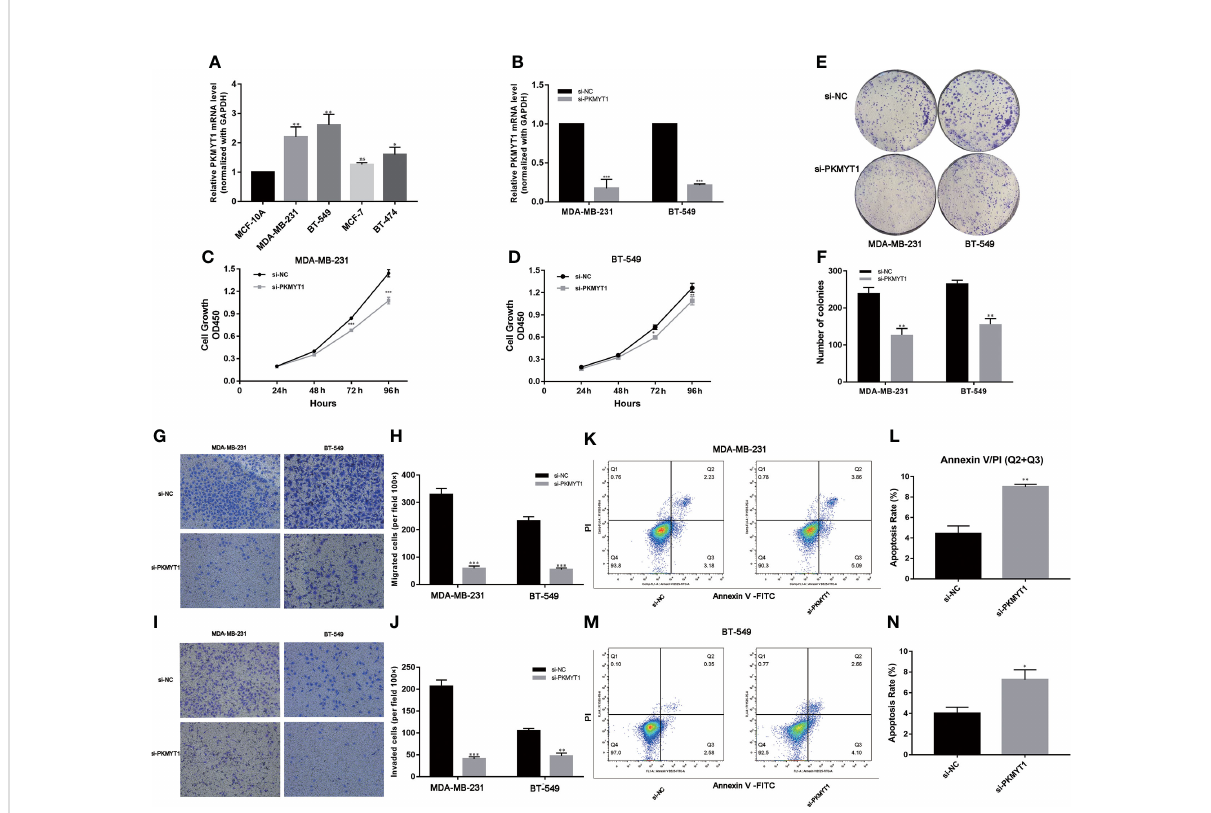
FIGURE 8 PKMYT1 promoted proliferation, colony formation, migration, invasion, and suppressed apoptosis in TNBC cell lines. (A) The qRT-PCR results showed PKMYT1 was up-regulated in TNBC cell lines. (B) The mRNA level of PKMYT1 in MDA-MB-231 and BT-549 TNBC cells transfected with si-NC and siPKMYT1. (C, D) Cell proliferation assay. (E, F) Colony formation assay. (G – J) Analysis of the effect of PKMYT1 on the migration and invasion of MDA-MB-231 and BT-549 cells. (K, L) The effect of PKMYT1 on MDA-MB-231 cells apoptosis by fl ow cytometry. (M, N) The effect of PKMYT1 on BT-549 cells apoptosis. * p < 0.05; ** p < 0.01; *** p < 0.001. ns, no signi fi